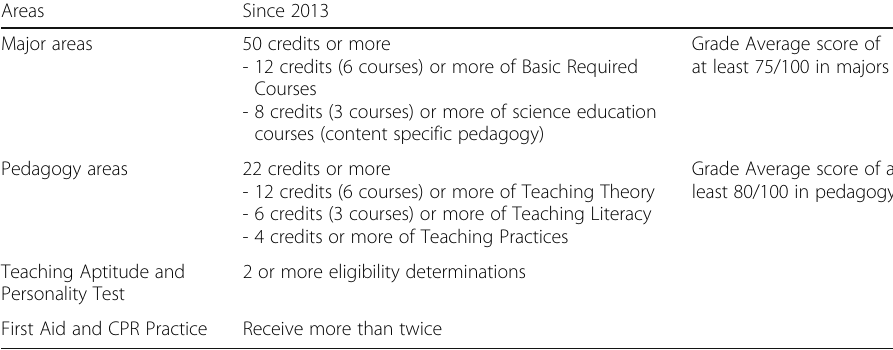
Table 3 Criteria for passing the no-test exam for science teacher candidates Areas Since